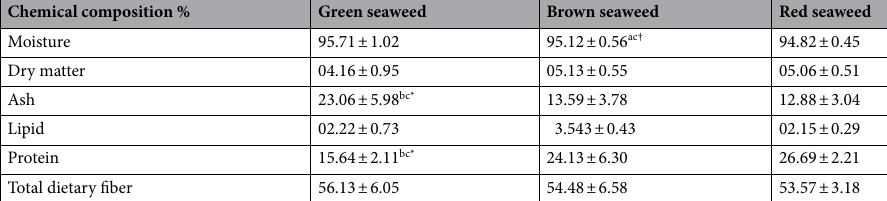
Table 3. Proximate composition values and the respective seaweed groups (mean ± SE). Data are expressed as values: mean ± SE of three replicates and analysed by one-way analysis of variance. a = when compared with green algae group, b = when compared with brown algae group, c = when compared with red algae group, ( * ) indicates statistically significant difference from respective group using ANOVA, followed by Tukey comparisons test (p > 0.05). (†) indicates statistically no significant difference from respective group using ANOVA, followed by Tukey comparisons test (p >